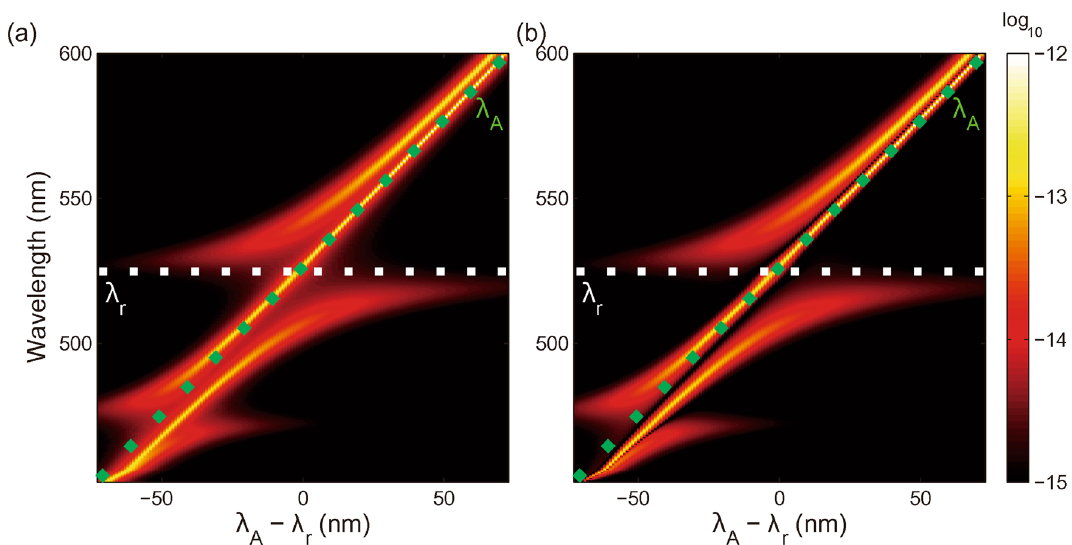
(cid:31) B (cid:31) r . The dotted white = �= (cid:31) B =